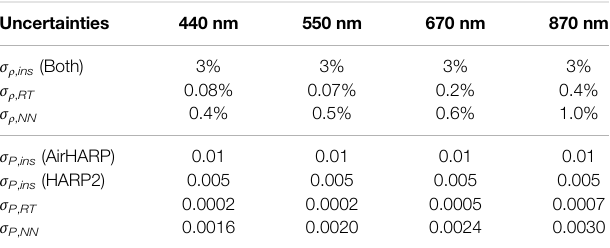
TABLE 2 | Uncertainties for re fl ectance ( ρ ) and DoLP (P) for both measurement and forward model used in this study including instrument uncertainty ( σ ins ), the radiative transfer simulation uncertainty ( σ RT ), and the NN uncertainty ( σ NN ). Different σ P , ins is used for AirHARP and HARP2 but with the same σ ρ , ins